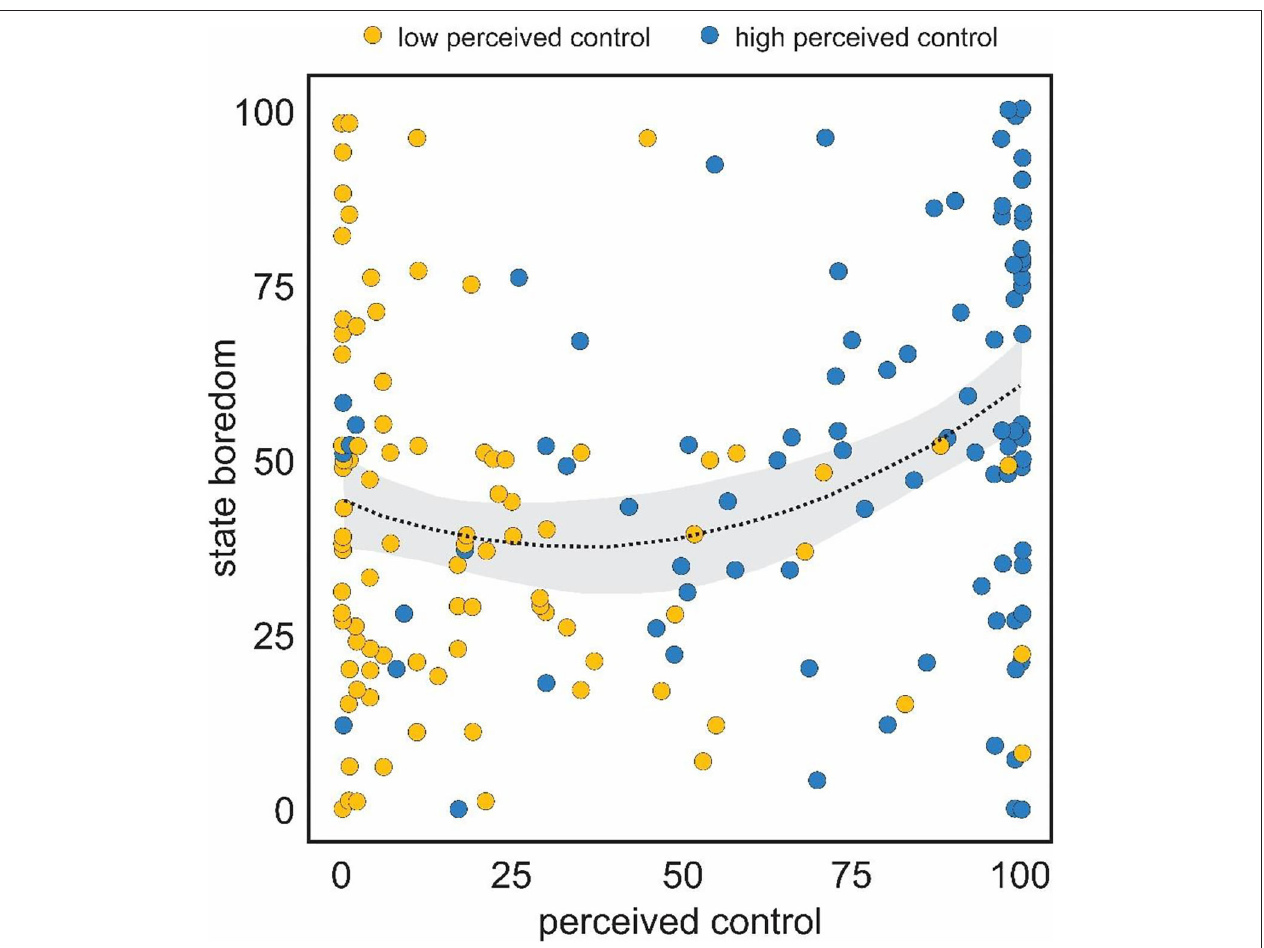
FIGURE 2 | Curvilinear relationship between self-reported ratings of state boredom (y-axis) and perceived control (x-axis). Boredom was highest at the low and high ends of perceived control.